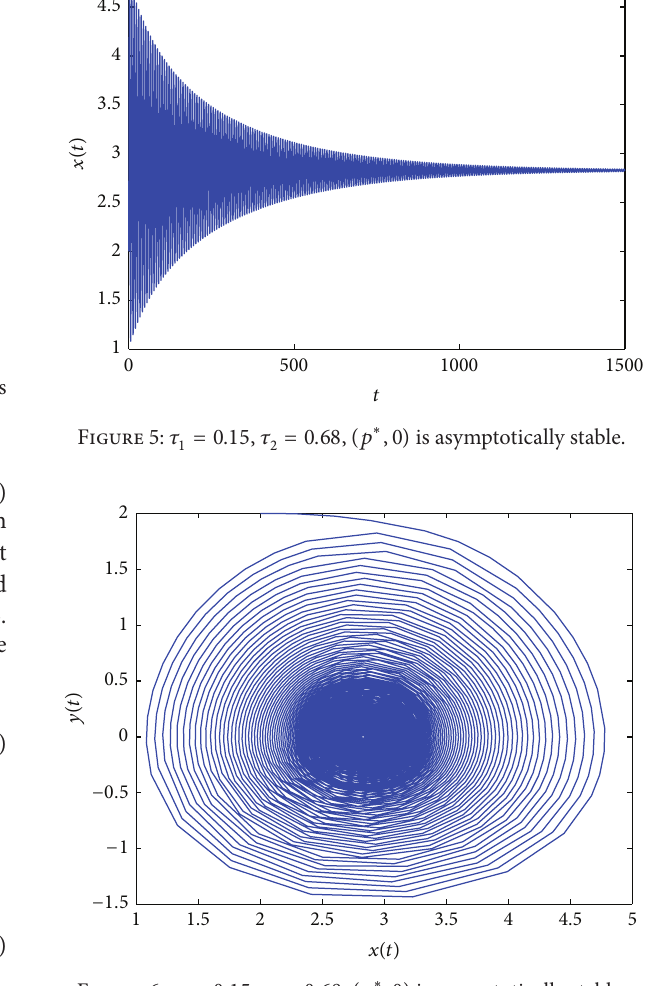
Figure 6: 𝜏 1 = 0.15 , 𝜏 2 = 0.68 , (𝑝 ∗ ,0) is asymptotically stable.